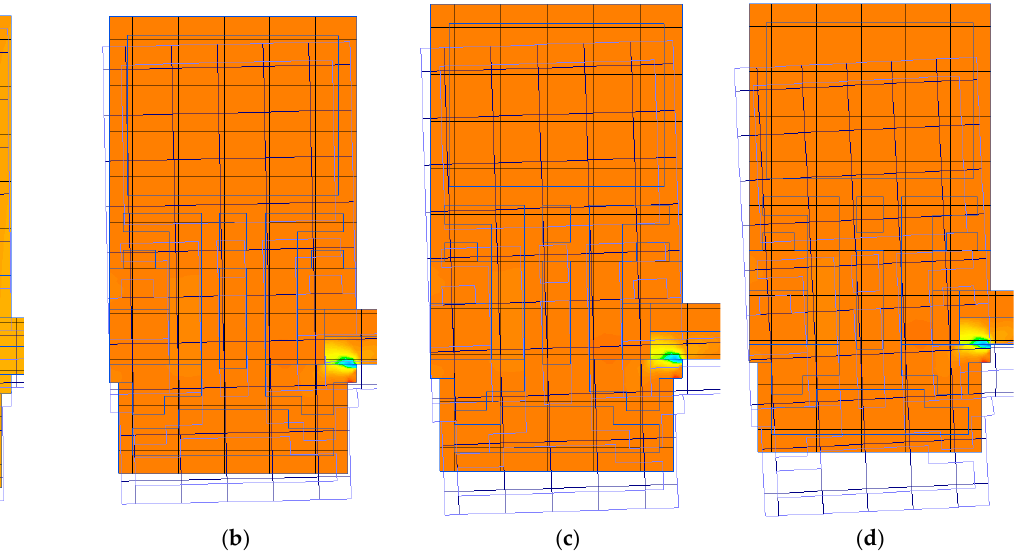
Figure 14. Deformations of the aluminum profile assembly used with the insulating glass unit of sample No. 2.4 as it was put under the action of a thermal load, at ( a ) 15 min, ( b ) 45 min, ( c ) 60 min and ( d ) 75 min.